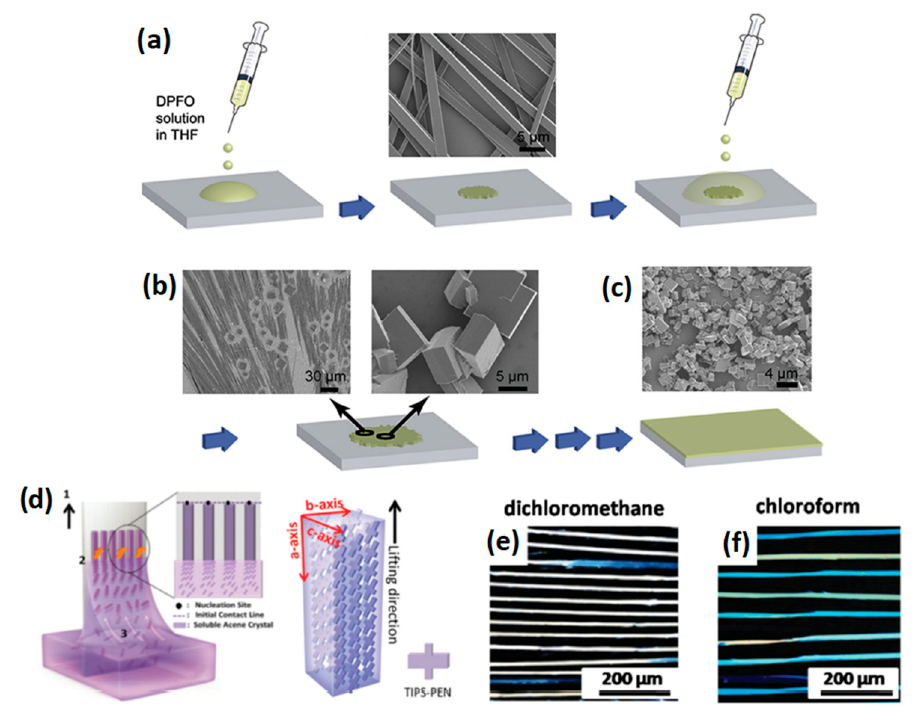
Figure 4. ( a – c ) Representation of the steps involved in the drop-casting method of microsized DPFO self-assembled crystals. Reproduced with permission from ref. [65]. Copyright 2015, Wiley-VCH. ( d ) Graphic illustration of dip coating process. ( e – f ) Cross polarized optical microscopy images of dip-coated TIPS-PEN crystals from ( e ) dichloromethane and ( f ) chloroform. Reproduced with permission from ref. [4]. Copyright 2016, Wiley-VCH.